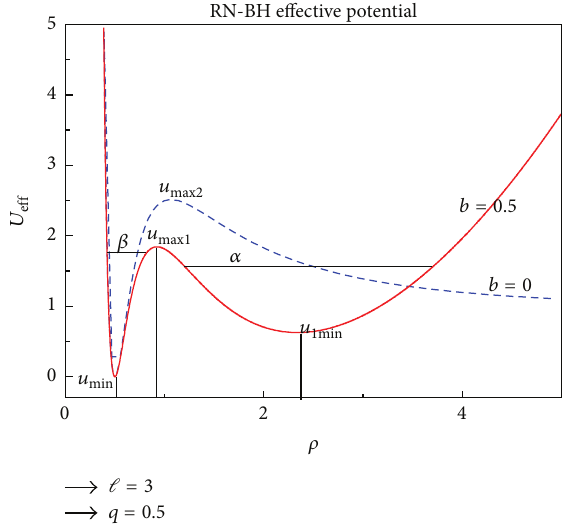
Figure 6: Behavior of effective potentials (34) with and without magnetic field versus 𝜌